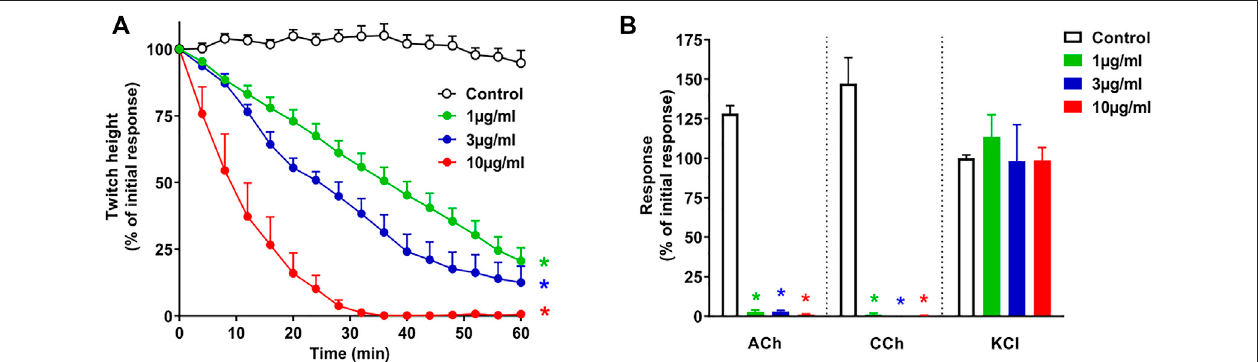
FIGURE 1 | Concentration-dependent in vitro neurotoxicity of O. hannah venom (1 – 10 μ g/ml) on (A) indirect twitches and (B) responses to exogenous agonists ACh (1 mM), CCh (20 µM) and KCl (40 mM) in the chick biventer cervicis nerve-muscle preparation. * p < 0.05, signi fi cantly different from (A) control at 60 min (one-way ANOVA; n = 4) or (B) pre-toxin response to same agonist (paired t -test, n =